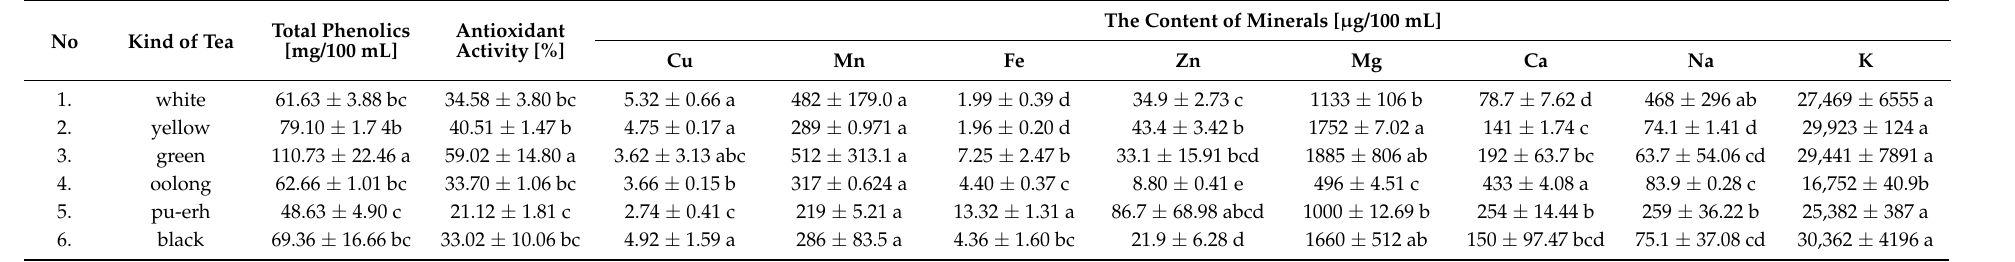
Table 2. The average values of selected biologically active components determined in particular types of tea